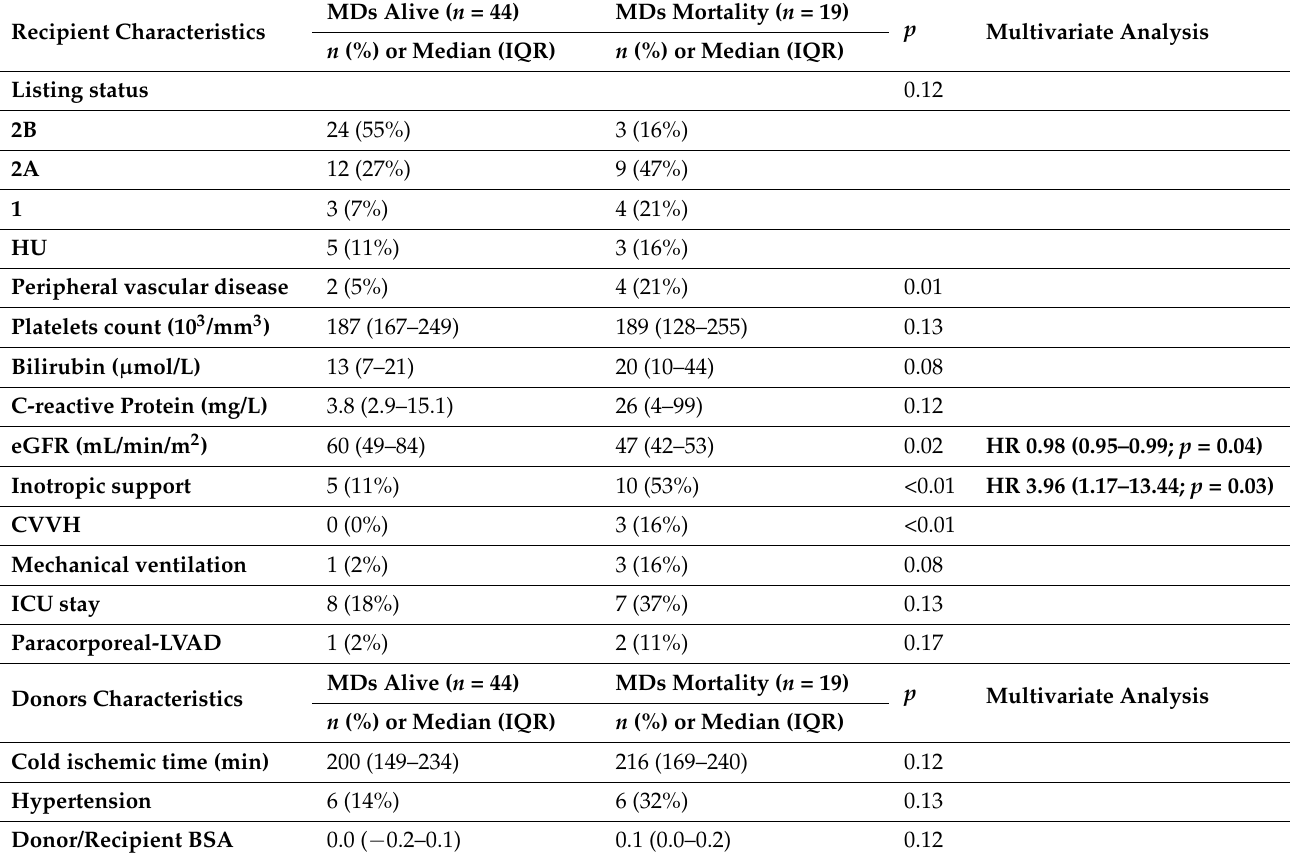
Table 4. Univariate and multivariate analysis of organ recipients from marginal donors for mortality.